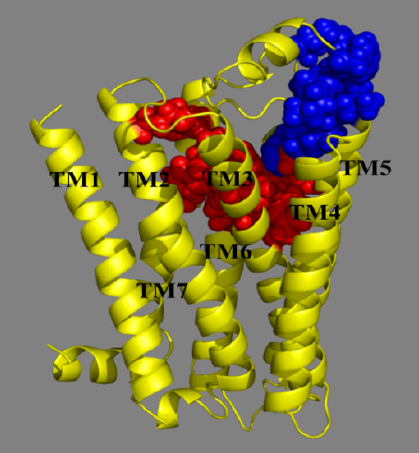
Figure 11. Two binding sites of MCHR1. P1 are depicted in red located between TMs 3, 5–7. P2 is depicted in blue between TMs